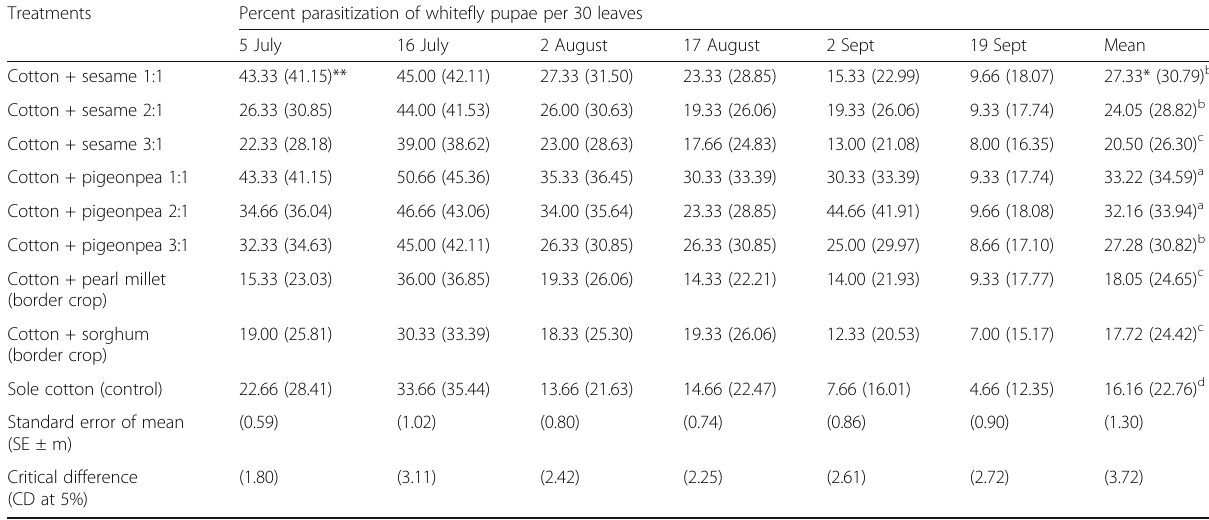
Table 1 Effect of intercropping on parasitization of whitefly pupae by Encarsia spp. in cotton (pooled of 2016 and 2017)